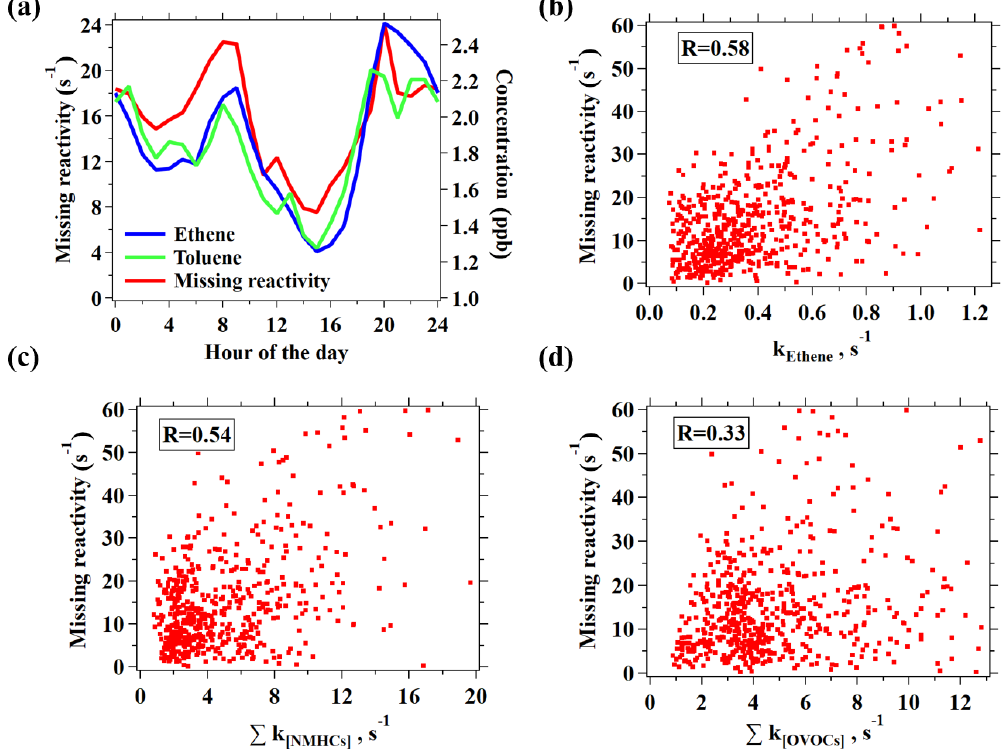
Figure 9. (a) Diurnal variation in hourly averages for missing reactivity and ethene concentration. (b–d) Correlation plots of the missing reactivity versus the reactivity of ethene (b) , NMHCs measured by GC–MS/FID, and PTR-ToF-MS (c) and OVOCs measured by PTR-ToF- MS, including common OVOCs and novel OVOCs (d)